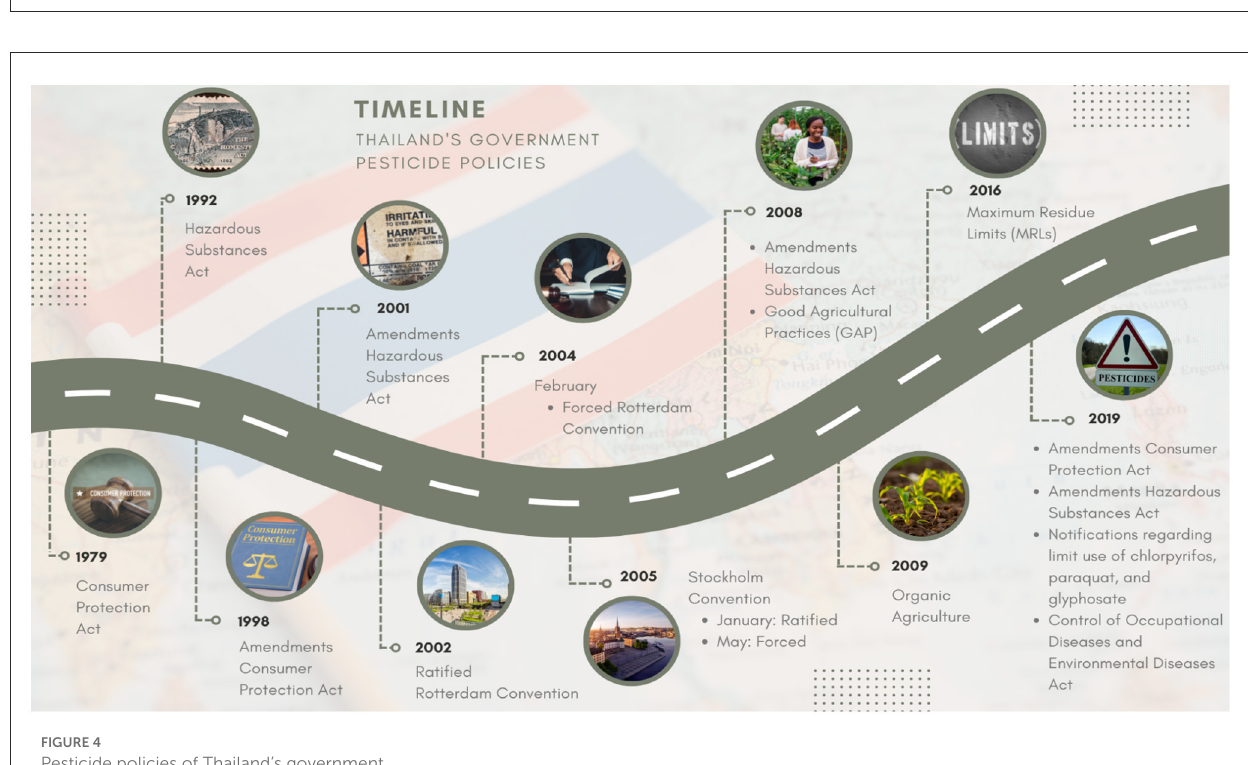
FIGURE4 Pesticide policies of Thailand’s